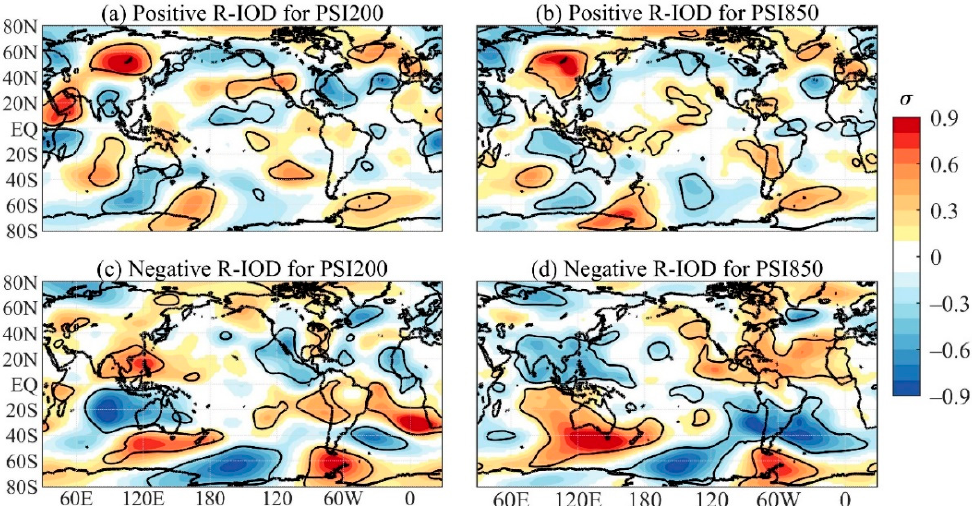
Figure 10. Composites of the residual zonally asymmetric streamfunction anomalies during austral spring for the: ( a ) positive R-IOD and PSI200; ( b ) positive R-IOD and PSI850; ( c ) negative R-IOD and PSI200; and ( d ) negative R-IOD and PSI850. In this Figure, residual means without the TPO effects. Graphical display is the same as that in Figure 5.